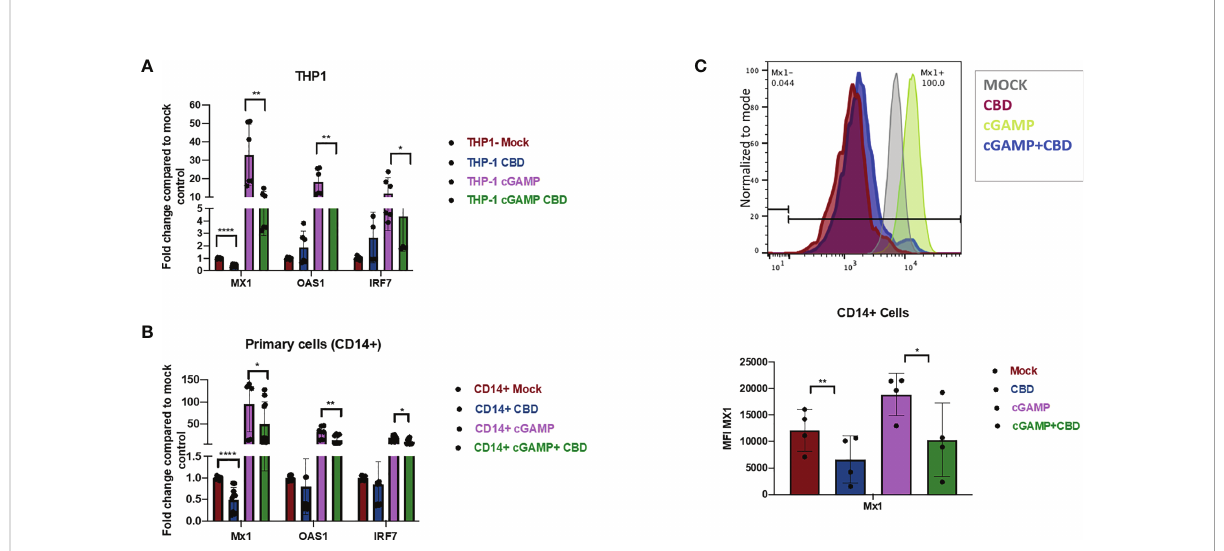
FIGURE 2 CBD down regulates the expression of ISGs in monocytic cell line THP-1 and primary macrophages. (A) THP-1 cell lines were treated with vehicle or CBD overnight and stimulated with or without 2 ’ 3 ’ -cGAMP for 8hrs. Expression levels of ISGs MX1, OAS1, IRF7 was measured by real time PCR. (B) CD14+ cells were sorted from healthy PBMCs followed by differentiation with M-CSF for 5 days. Afterwards, cells were treated with CBD for 8hrs. Expression levels of MX1, OAS1, IRF7 was measured by real time PCR. (C) ISG Mx1 protein in CD14+ primary macrophages were measured by fl ow-cytometry. *p<0.05, **p<0.005,